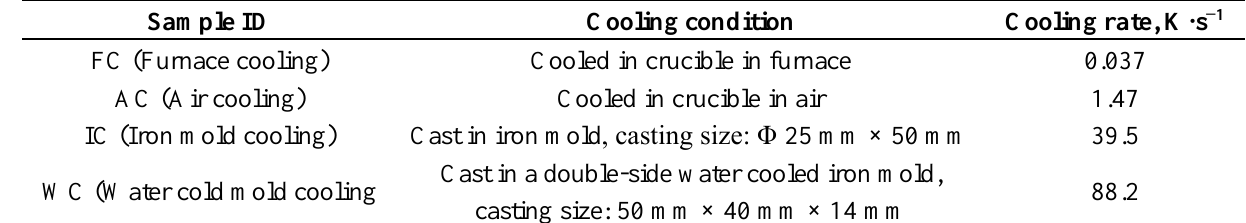
Table 1. Summary of cooling